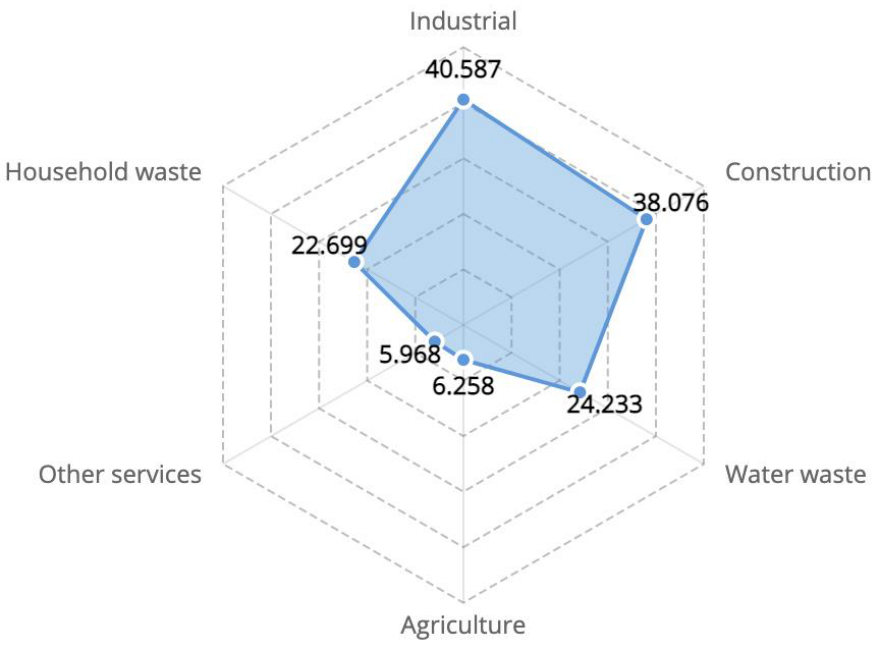
Figure 1. Waste-producing sectors in Spain. Data is represented in thousands of tons—source: own elaboration with data collected from Retama [14].